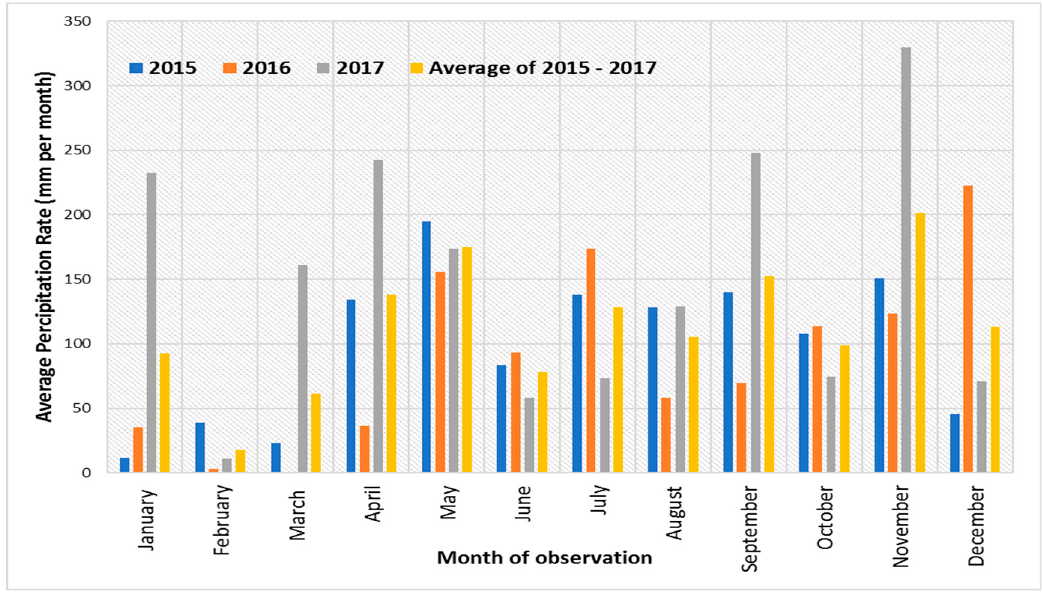
Figure 3. Precipitation rates in Perlis per month for the year 2015, 2016 and 2017 and overall average.